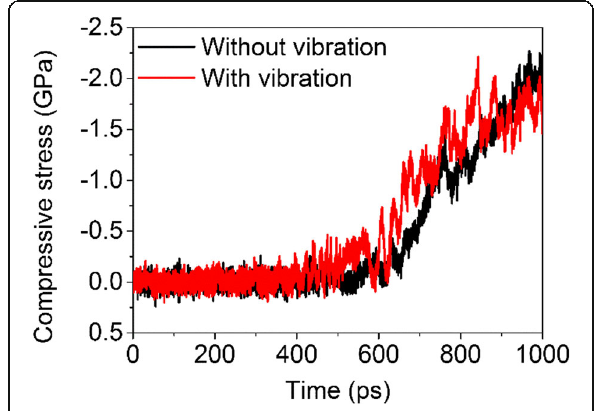
Fig. 11 Compressive stress as a function of time for the finial sintered particles with and without system vibration